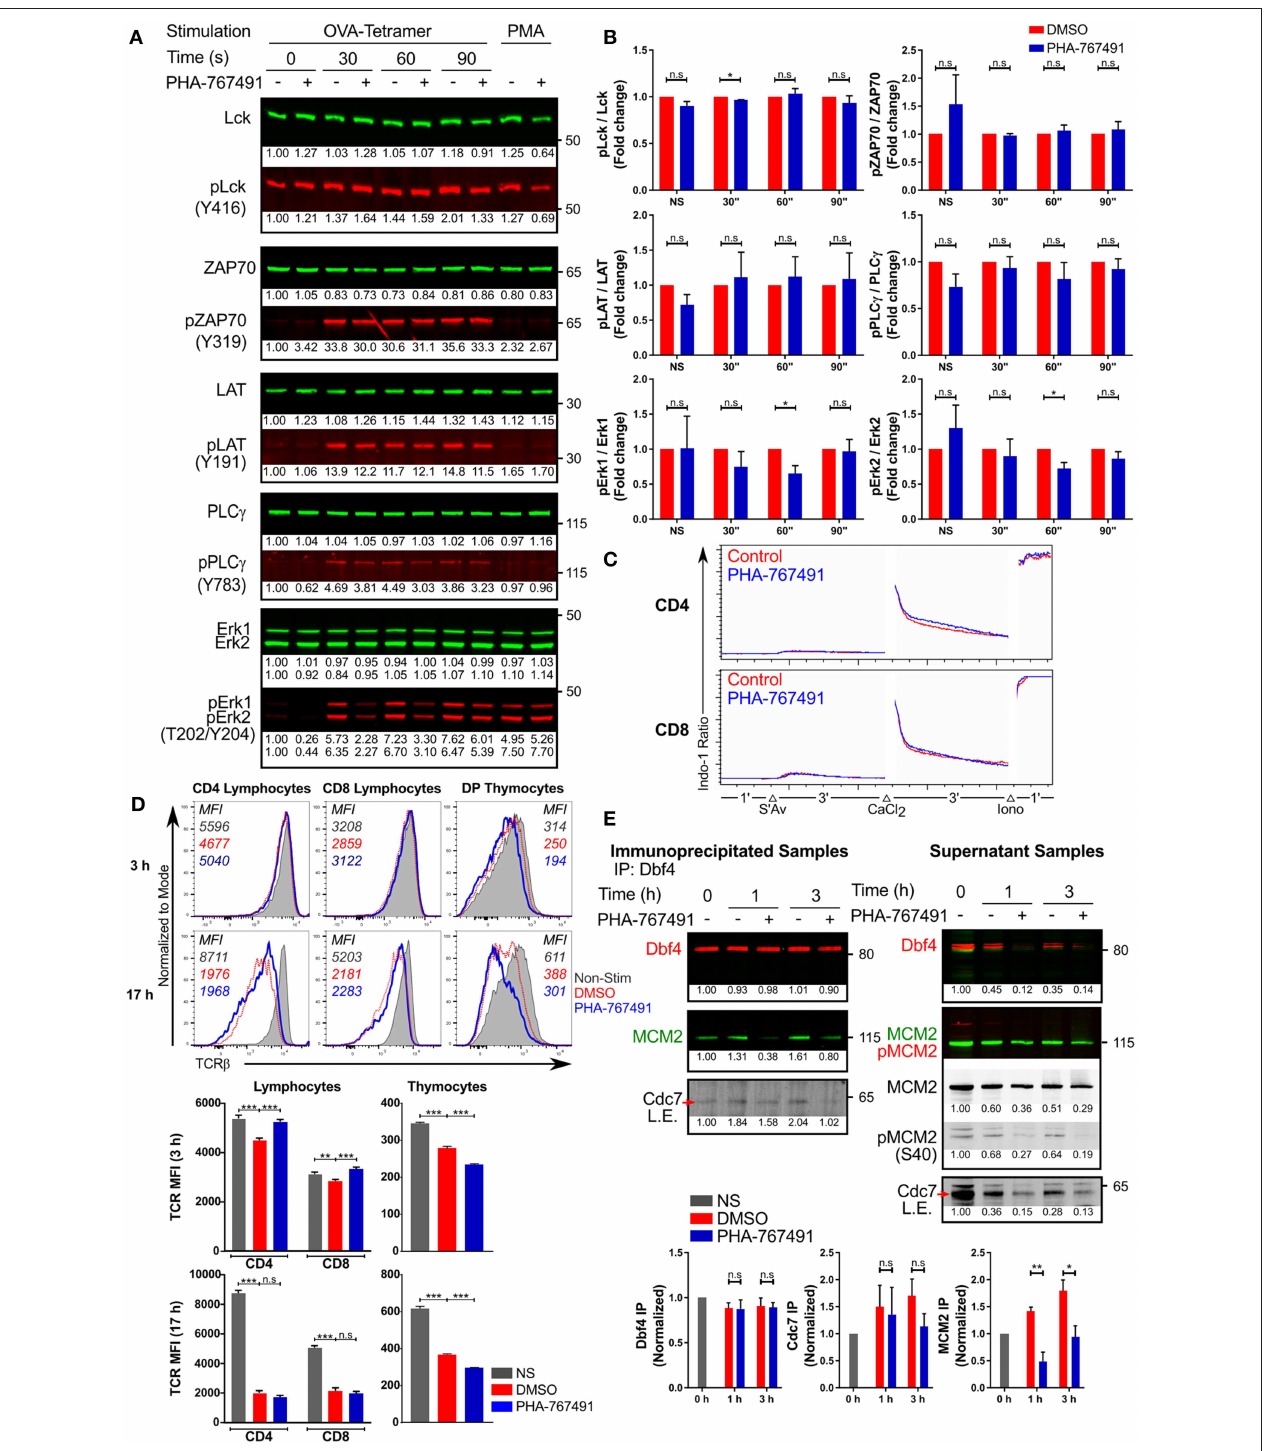
FIGURE 7 | PHA-767491 modulates TCR signaling. (A) PHA-767491 treatment suppresses Erk phosphorylation. Immunoblots of OT-I CTL that were not-treated (–) or were treated ( + ) with PHA-767491 were stimulated with K b -OVA tetramers for the indicated times. Normalized values of individual bands are indicated below the respective bands. Representative blots of at least three independent experiments are shown. (B) The ratio of the band intensities of the phosphorylated proteins to the respective total proteins from (A) are shown in the bar charts, depicted as mean ± SEM. Values represent fold change, normalized to the DMSO-treated